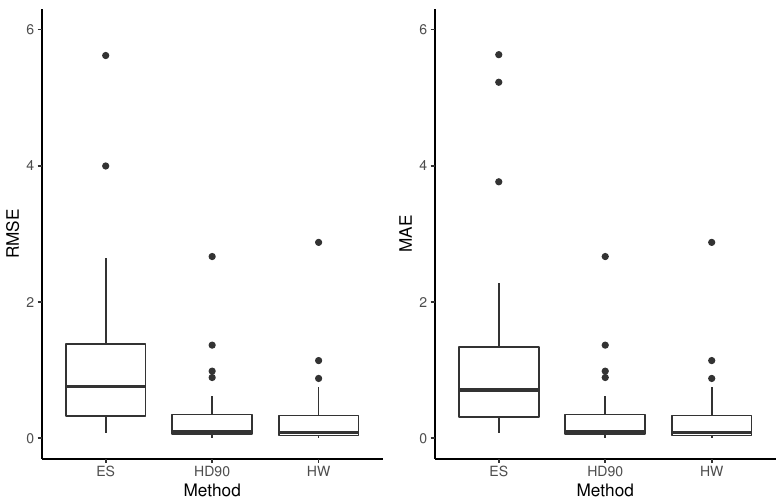
Figure 7. Side-by-side boxplots of RMSE ( left ) left and MAE ( right ) across three different methods- exponential smoothing (ES), Holt Winter Trend only (HW), and the damped Holt with the damping factor 0.90